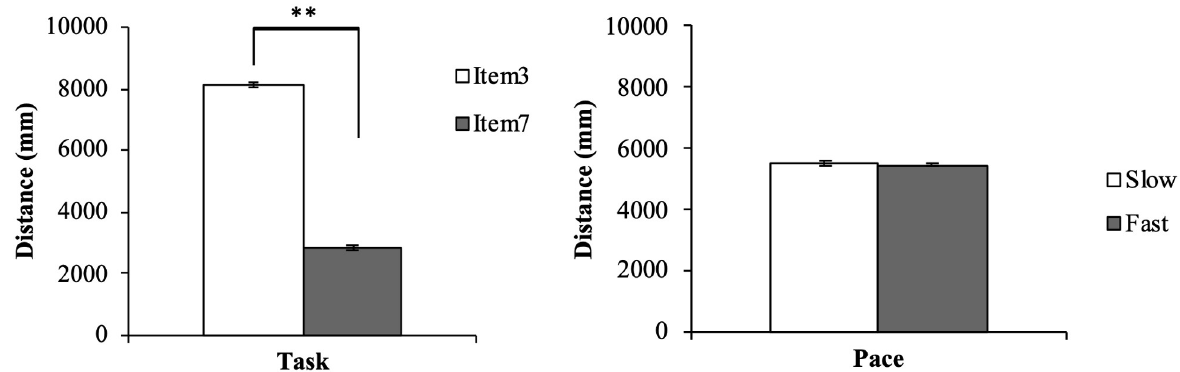
Fig 4. Two-way repeated-measures ANOVA for distance. Distance represents the distance of the upper limb movement, �� p < 0 . 01 , � p < 0 . 05 .